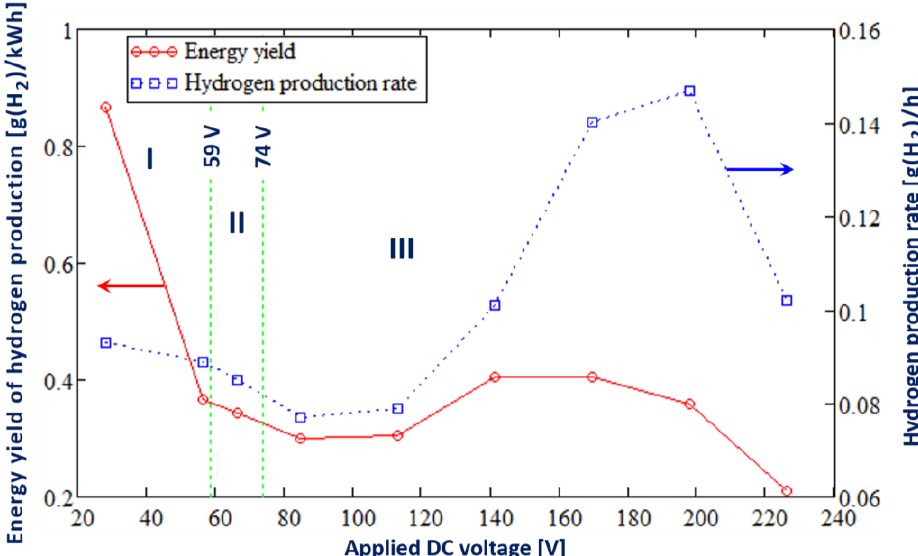
Figure 4. Influence of the applied DC voltage on the energy yield and rate of hydrogen production in the DC electrolysis of a 10 wt% Na 2 CO 3 aqueous solution for 3 regimes: the Faradaic (marked I), transition (marked II), and PDSE (marked III) regimes.